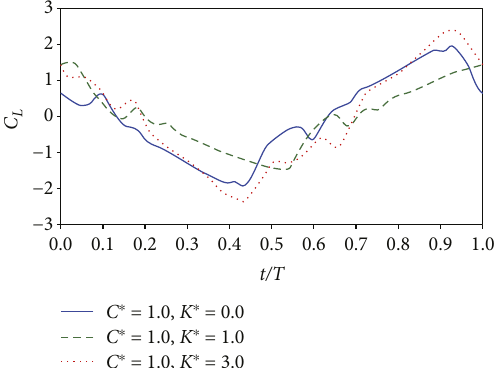
Figure 8: The time variation of lift coe ffi cient of the considered cases with K ∗ = 0 0 , 1.0, and 3.0, C ∗ = 1 0